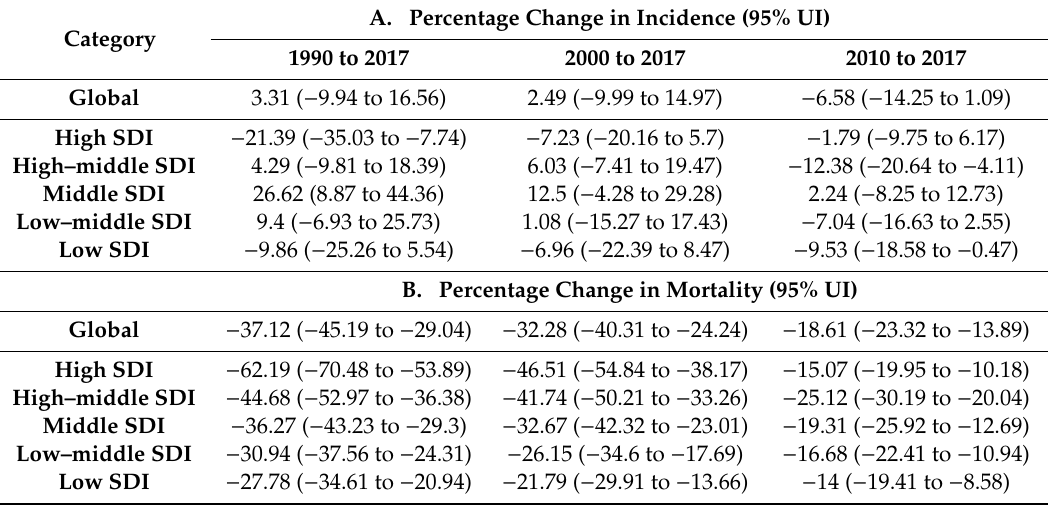
Table 2. Incidence (A) and mortality trends (B) for pedestrian road tra ffi c injuries (PIs)